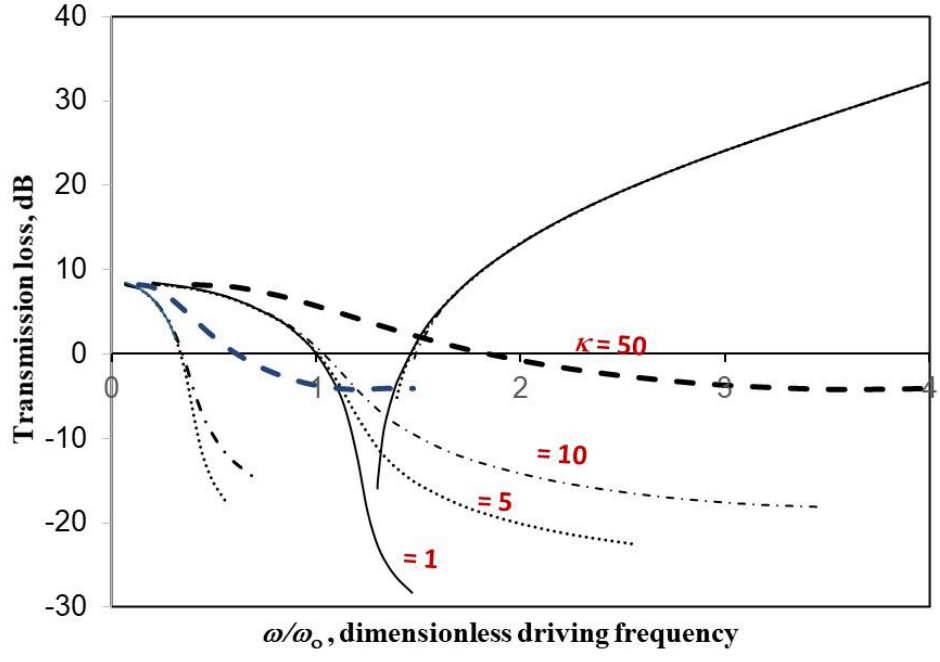
Figure 3. Amplitude ratio versus excitation frequency for various excitation magnitudes ( c/a = 0.5, ξ = 0.02, single cavity).